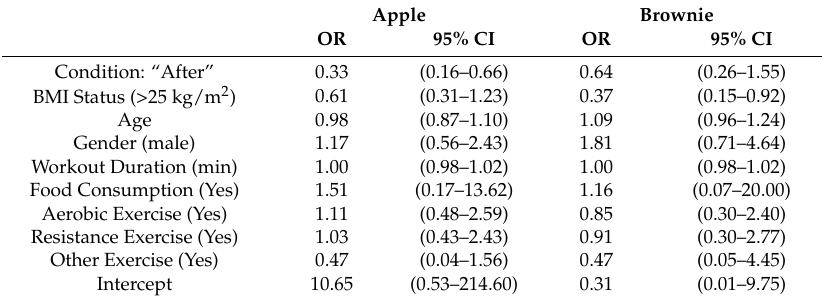
Table 2. Odds ratios (OR) and 95% confidence intervals (CI) from multinomial logistic regression results of snack choice, relative to